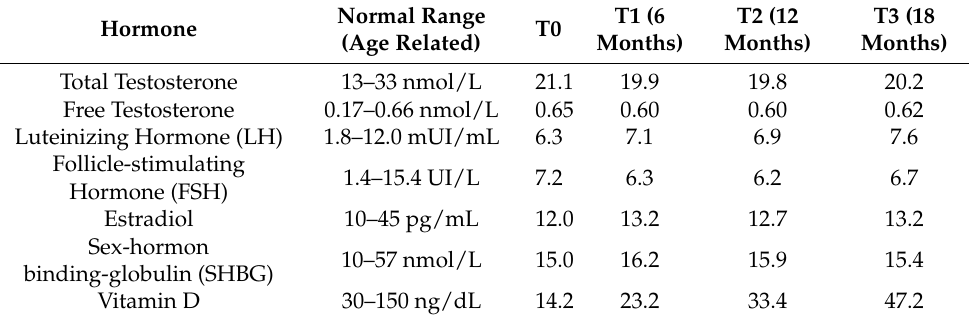
Table 1. Hormone levels during follow ‐ up period .